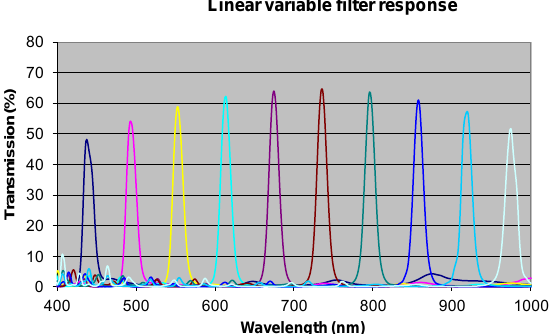
Figure 7: spectral response measurement of the linear variable filter measured at ten points along the variable axis of the filter